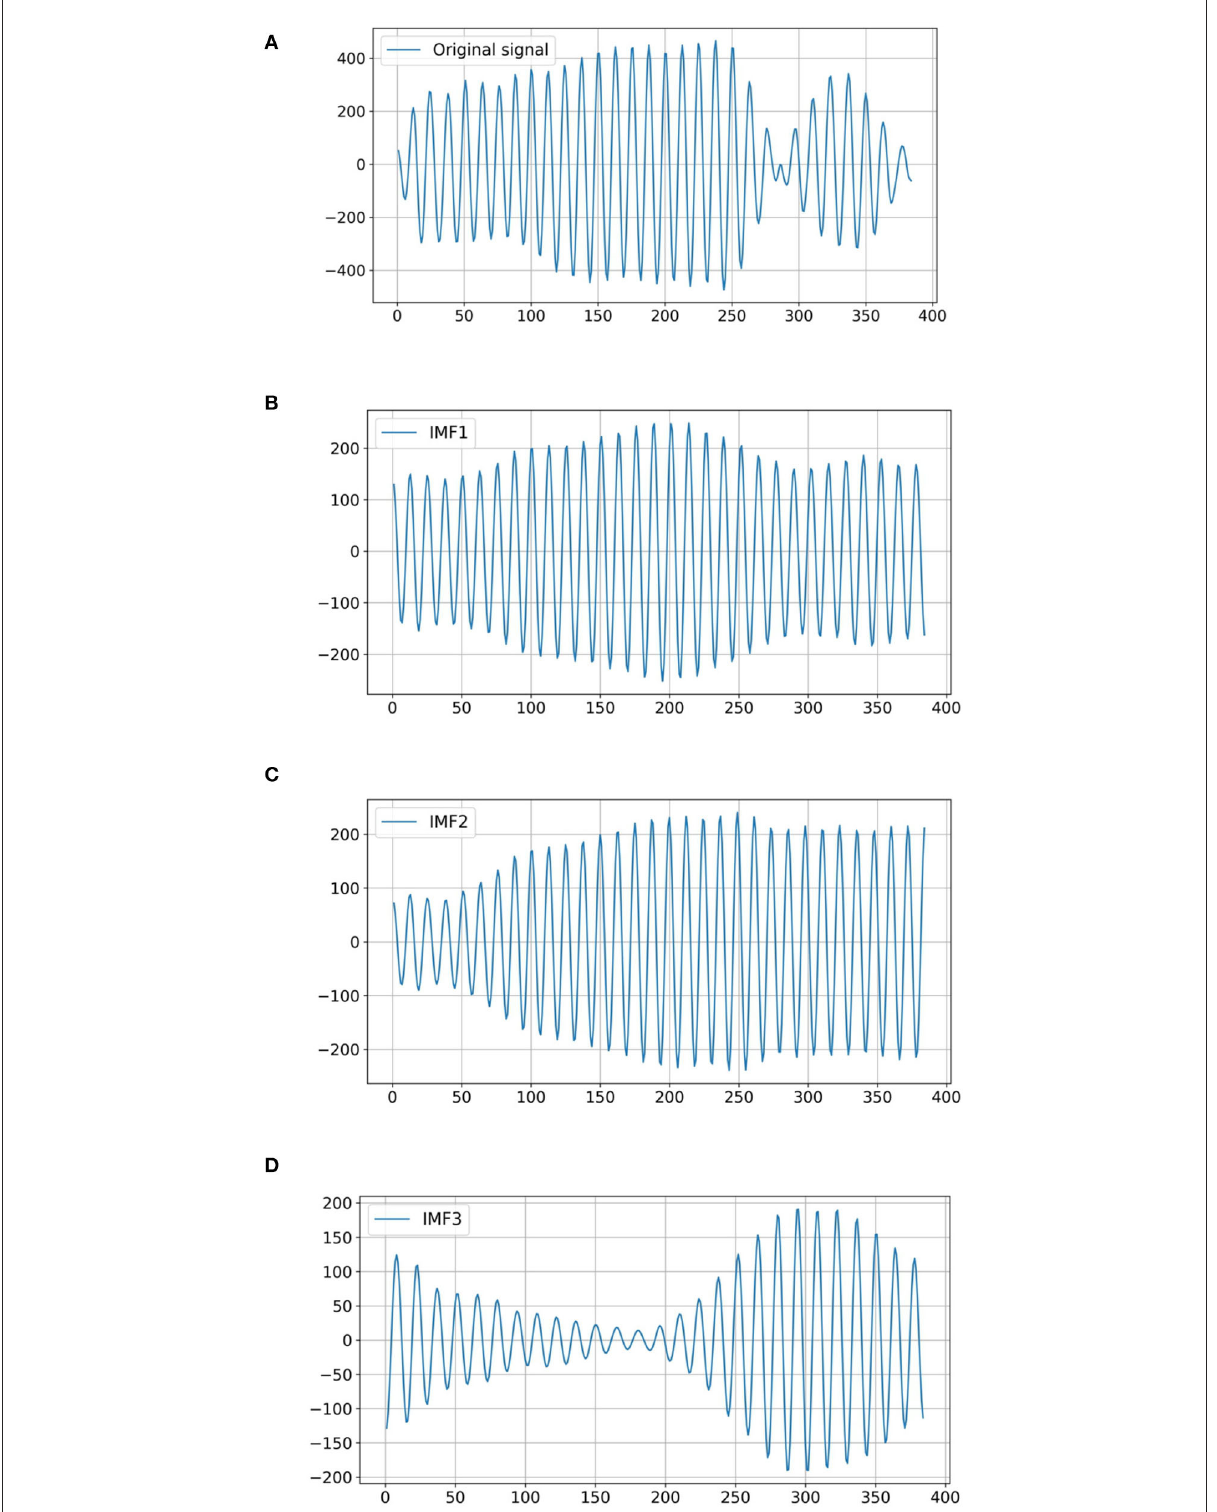
FIGURE4 The VMD decomposition from the air-coupled ultrasonic signal of a cottonseed with slight crack. (A) Original signal. (B) IMF1. (C) IMF2. (D)